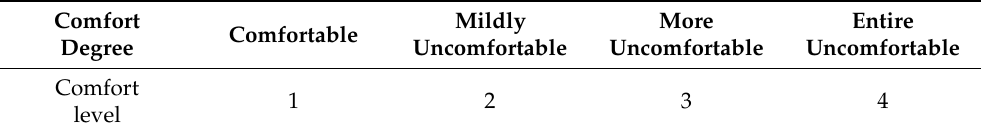
Table 6. Partial lower extremity comfort feature dataset.